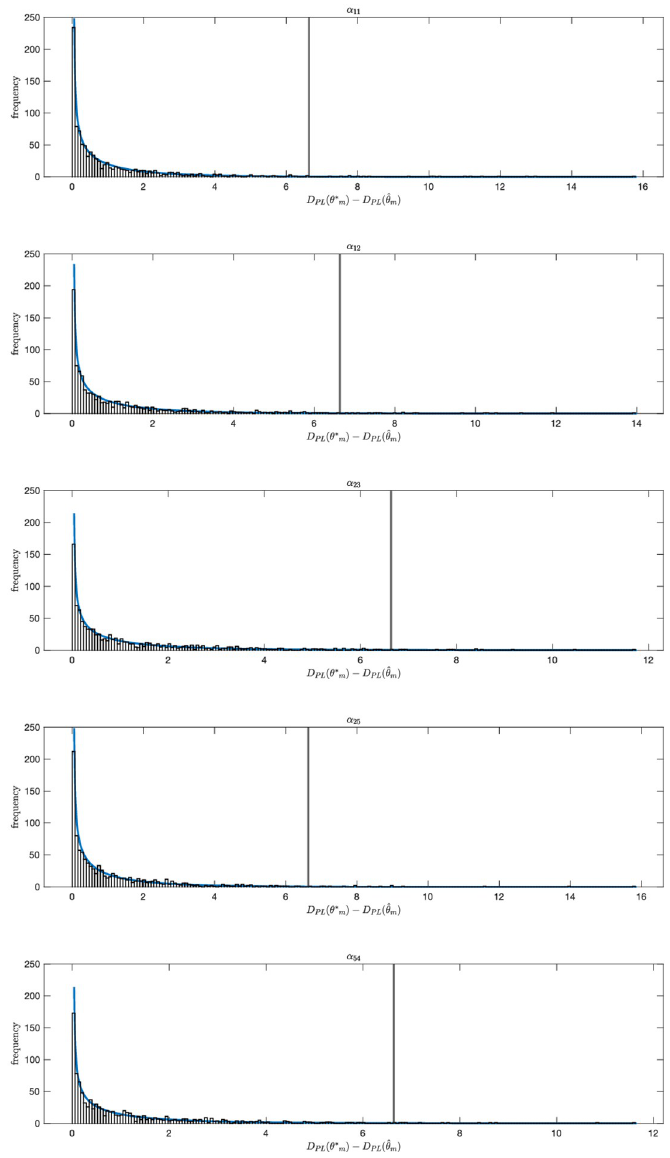
Fig 9. Validation of the coverage of the confidence intervals. The χ 2 distribution with one degree of freedom (blue) and, for a 1000 independent datasets, and for five edge parameters θ m 2 θ of the 10-edge 5 cytokine test model, a histogram of the values of D ð y � Þ (cid:0) D ð ^ y Þ , with D ð y Þ ¼ min (cid:0) 2 log ð L ð θ ÞÞ , ~ θ PL PL m PL m m ~ θ m Here, y � ¼ 0 : 5 is the true value of θ m and ^ y its estimated value by log-likelihood minimization. In 99% of all cases, the m value of D ð y � Þ (cid:0) D ð ^ y Þ is smaller than χ 2 (0.99, 1) (vertical grey line). PL PL m m